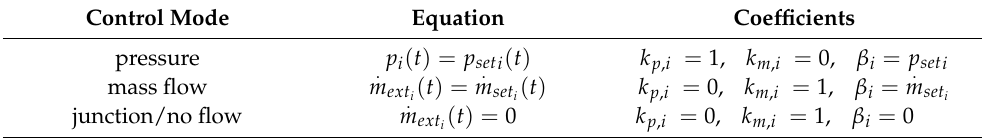
Table 1. Summary table for nodal possible control modes and corresponding boundary